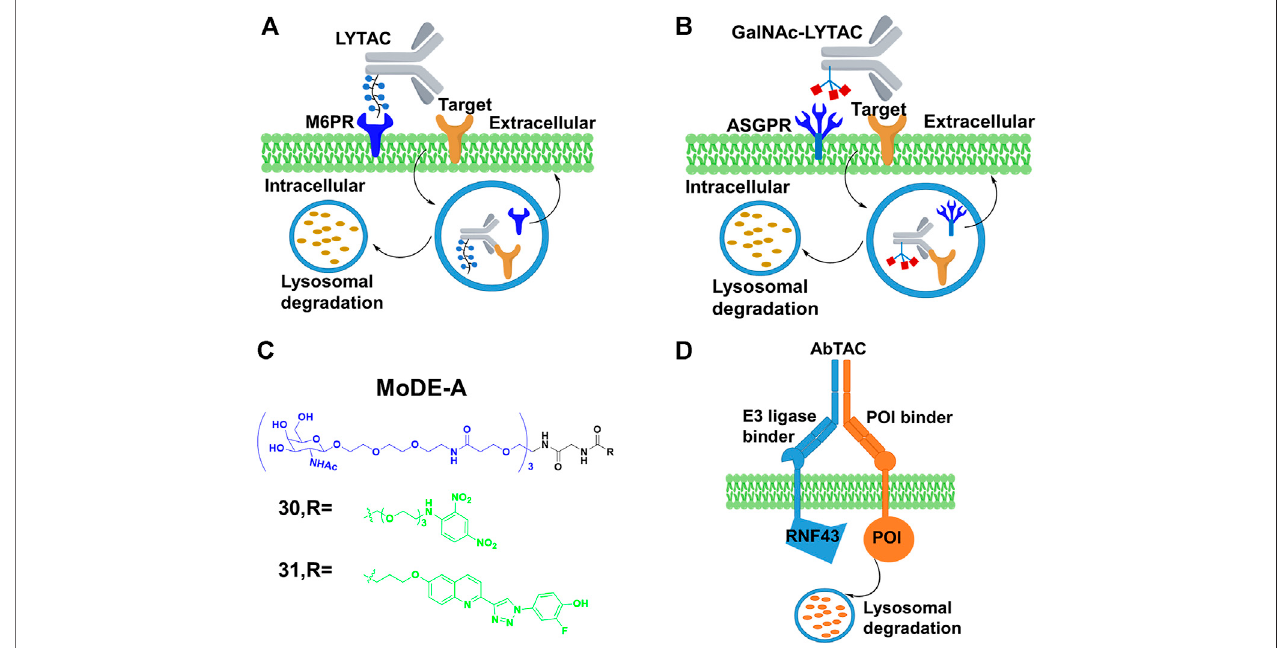
FIGURE10|(A) ActionmodeofLYTAC. (B) ActionmodeofN-acetylgalactosamine(GalNAc)-LYTAC. (C) Chemicalstructureofmoleculardegraderofextracellular proteins through the Asialoglycoprotein receptor (MoDE-A). (D) Action mode of antibody-based PROTAC (AbTAC).